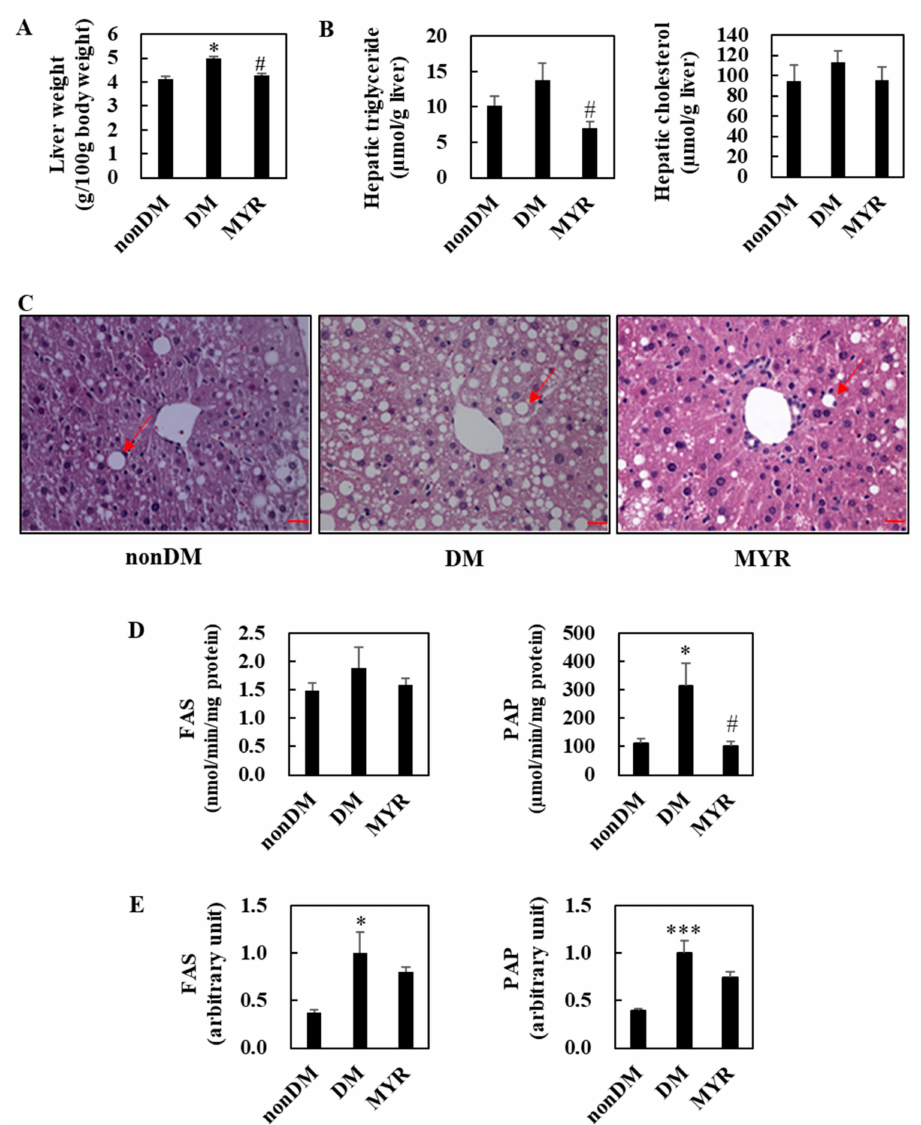
Figure 3. E ff ects of MYR on liver weight ( A ), hepatic lipids contents ( B ), liver morphology ( C ), and hepatic lipogenic enzymes activities ( D ) and mRNA expression ( E ) in HFD / STZ-induced diabetic mice. ( A , B , D , E ) Values are means ± SE ( n = 10). Student’s t -test was used to assess the di ff erences among groups.: * p < 0.05, *** p < 0.001; non-DM group versus DM group, # p < 0.05; DM group versus MYR group. ( C ) Representative images of hematoxylin and eosin stained liver sections. Arrows indicates lipid droplets. Scale bars represent 19 µ m. Magnification is 400 × . FAS: fatty acid synthase, PAP: phosphatidate